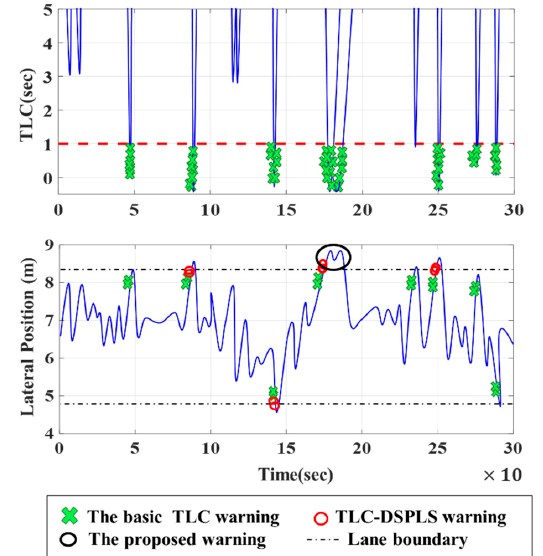
Figure 13. Comparison of alarm trigger position in three different warnings under TLC and lateral position. The basic TLC warning was triggered when the TLC value less than the threshold value (usually is defined as 1 s [18]).